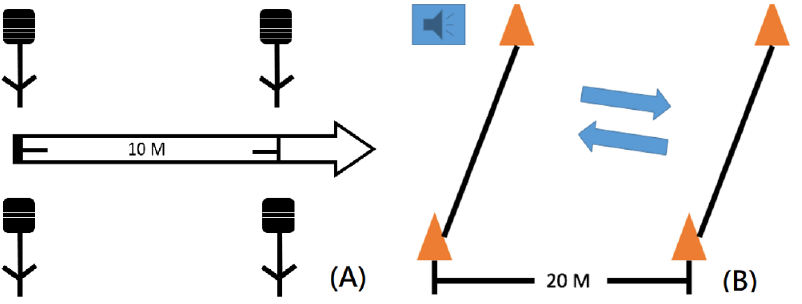
Figure 4. The field layout of ( A ) 10 m sprint, and ( B ) 20 m shuttle run.